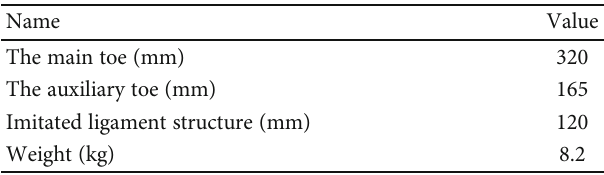
Figure 3: Bionic mechanical foot after fabrication and Table 1: Speci fi cations of the bionic mechanical foot.